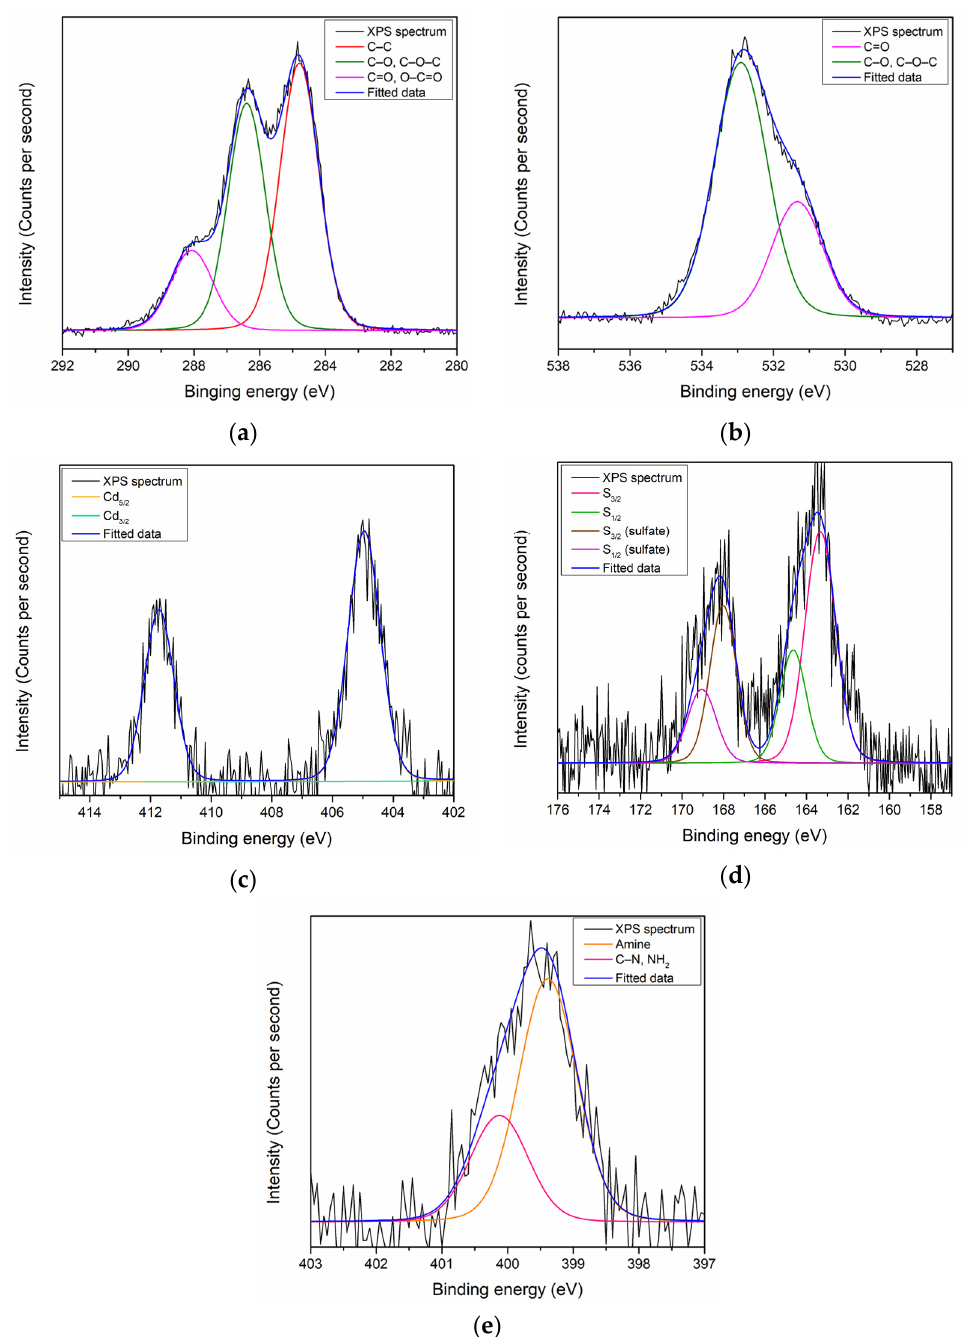
Figure 3. XPS narrow scan spectra of CdS QD–chitosan–GO for ( a ) C 1s; ( b ) O 1s; ( c ) Cd; ( d ) S 2p; and ( e ) N 1s.